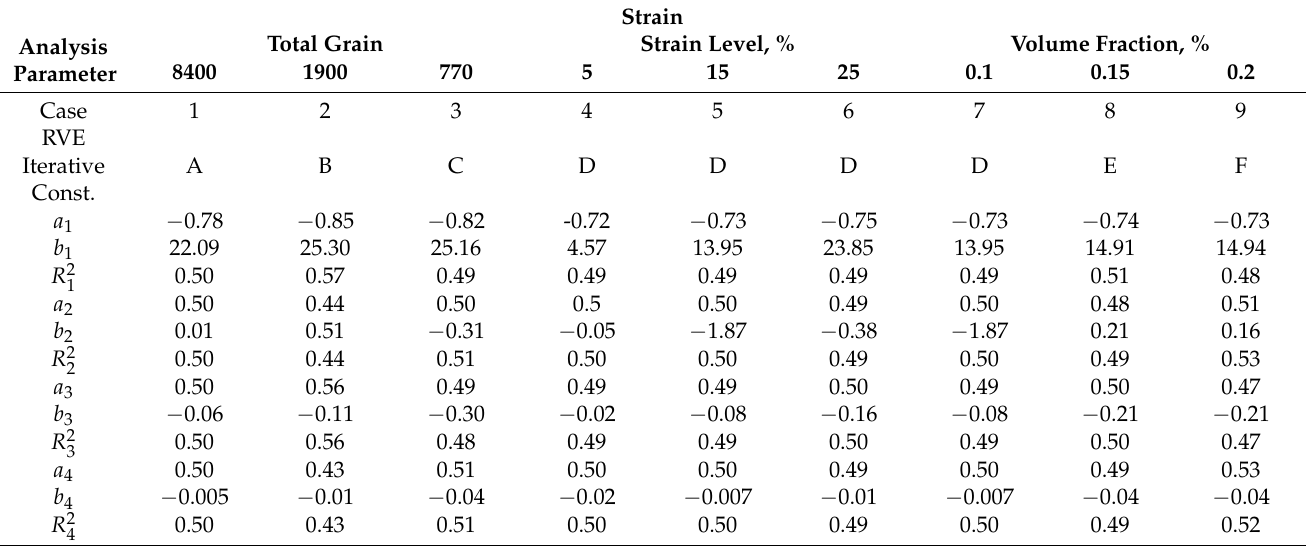
Table 4. Constants a m , b m , and R 2 m (m = 1, 2, 3, 4) for the ferrite phase of linear equation with strain condition by the proposed iterative method.